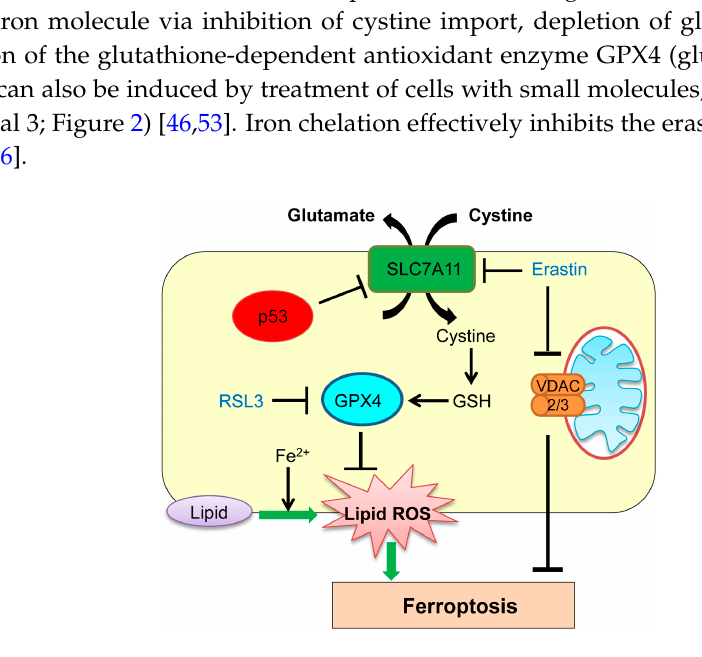
Figure 2. Role of p53 in ferroptosis. p53 transcriptionally represses solute carrier family 7 member 11 (SLC7A11), sensitizing cells to ferroptosis. GSH: glutathione; GPX4: glutathione peroxidase 4; ROS: reactive oxygen species; RSL3: Ras selective lethal 3; VDAC: voltage-dependent anion channels.